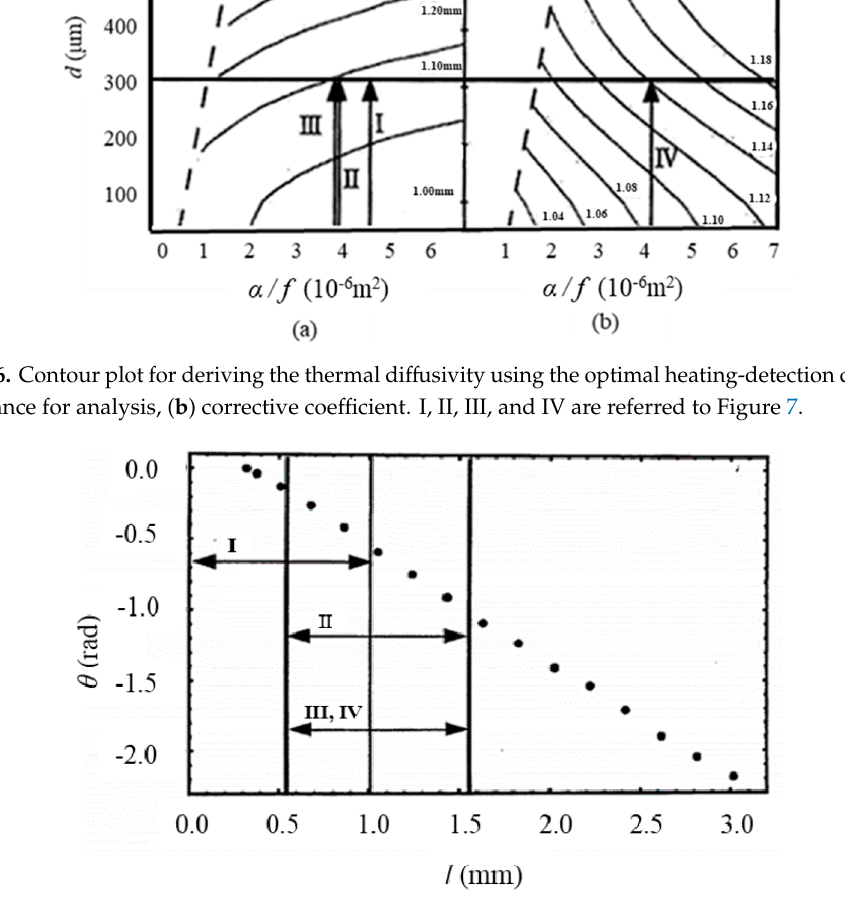
Figure 7. Results of phase lag measurements on copper samples.